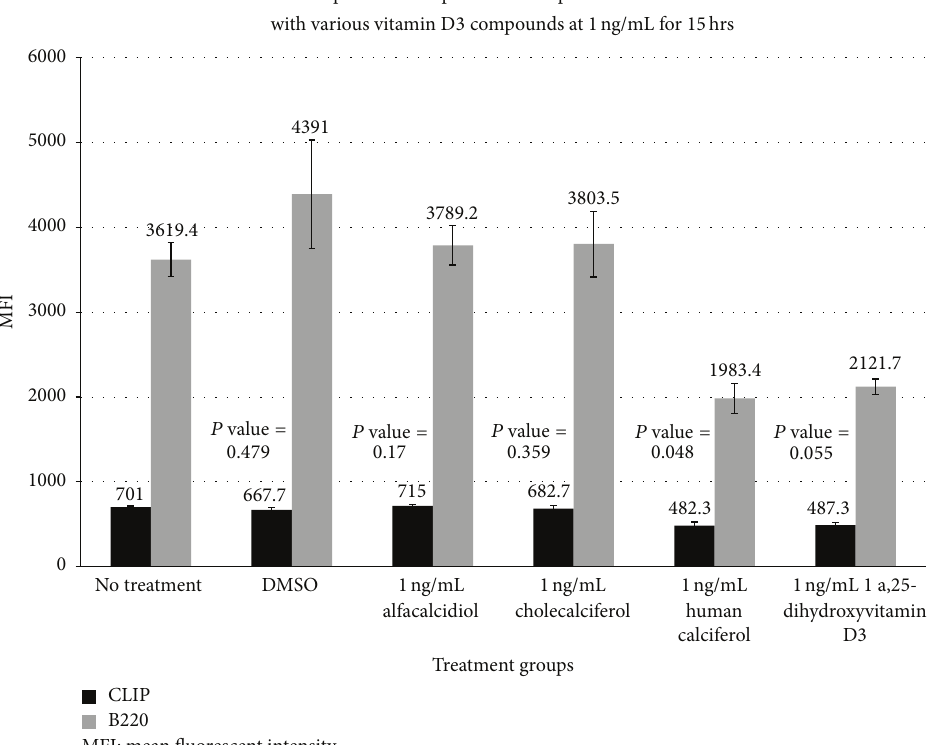
Figure 2: Bar graph showing the effects of 1 ng/mL of various vitamin D3 compounds on the distribution of TLR-activated CLIP + and B220 subsets of B cells. This figure demonstrates the changes in MFI of CLIP and CLIP + B220 subsets of B cells 15 hrs after administration of different compounds of vitamin D3 versus no treatment or DMSO (control). These results suggest that the active formulation of vitamin D3 may lead to a statistically significant reduction in CLIP expression on polyclonally activated splenic B cells. Administration of the human calcitriol of vitamin D3 ( 𝑃 = 0.048 ) resulted in the greatest overall reduction in the MFI (482.3 versus a baseline of 701.1) for CLIP expression on stimulated B cells. Administration of the active form of vitamin D3 again resulted in statistically significant reduction in CLIP expression on CpG-activated B